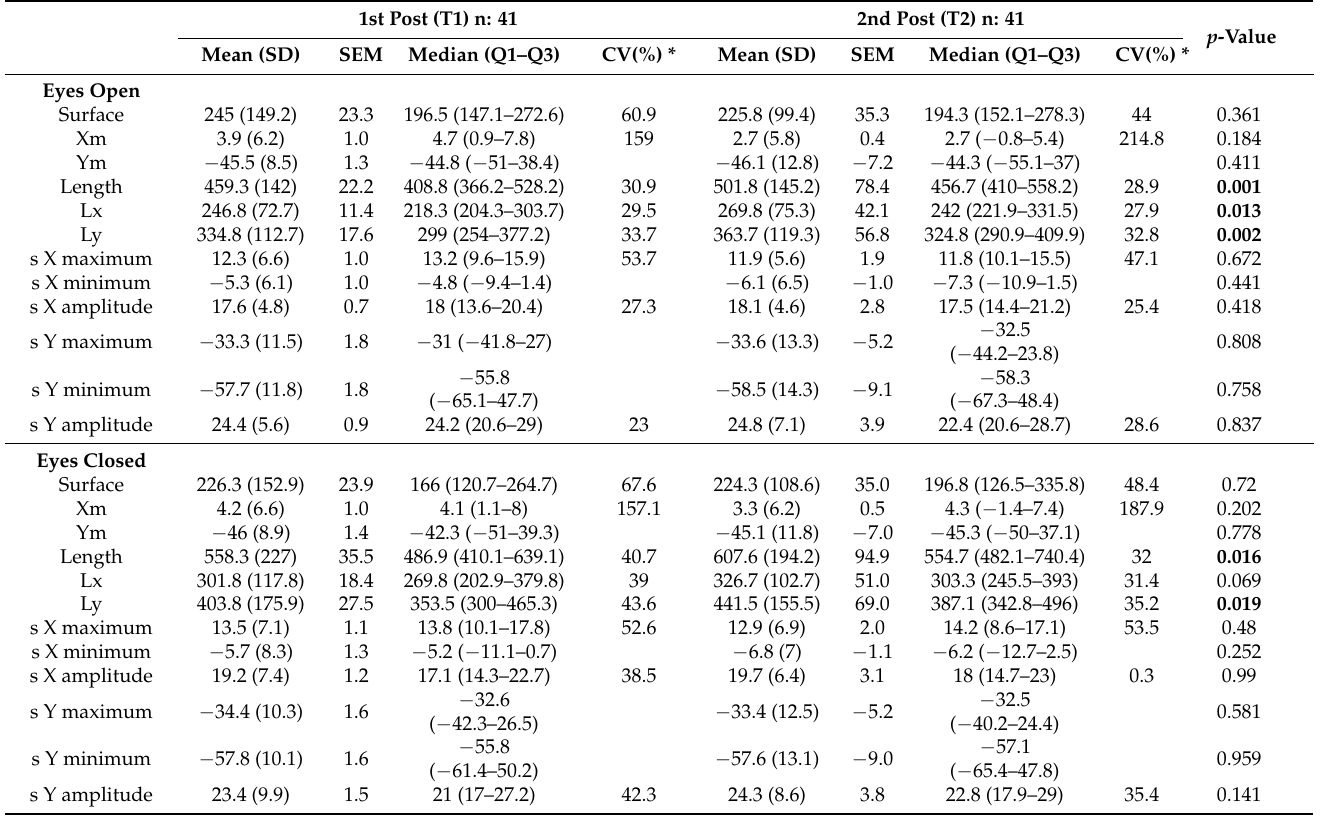
Table 3. Comparison between first and second post intervention with eyes open and closed.